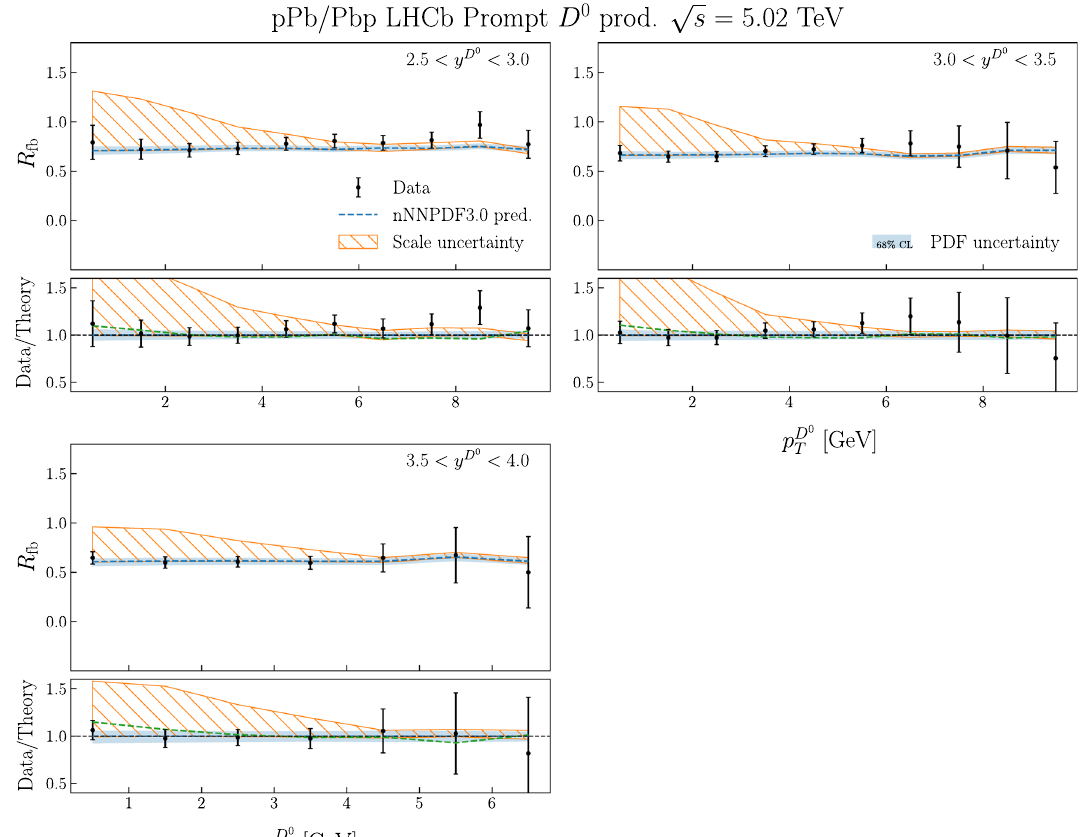
Fig. 25 ComparisonbetweentheLHCbdataontheratioofforward-to- backward measurements R fb and the corresponding theoretical predic- tions based on nNNPDF3.0 (which includes instead the data on R pPb ).